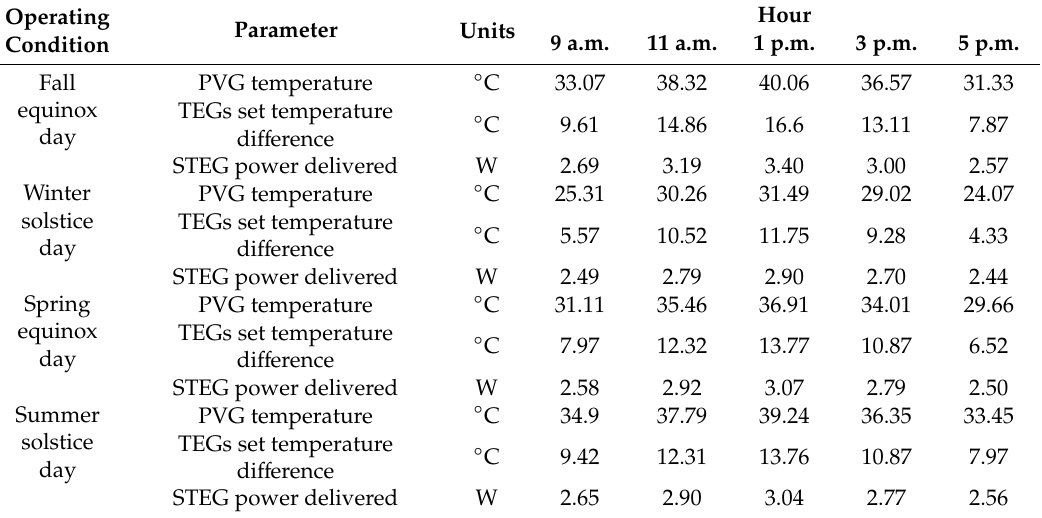
Table 5. STEG device power delivered under di ff erent operating